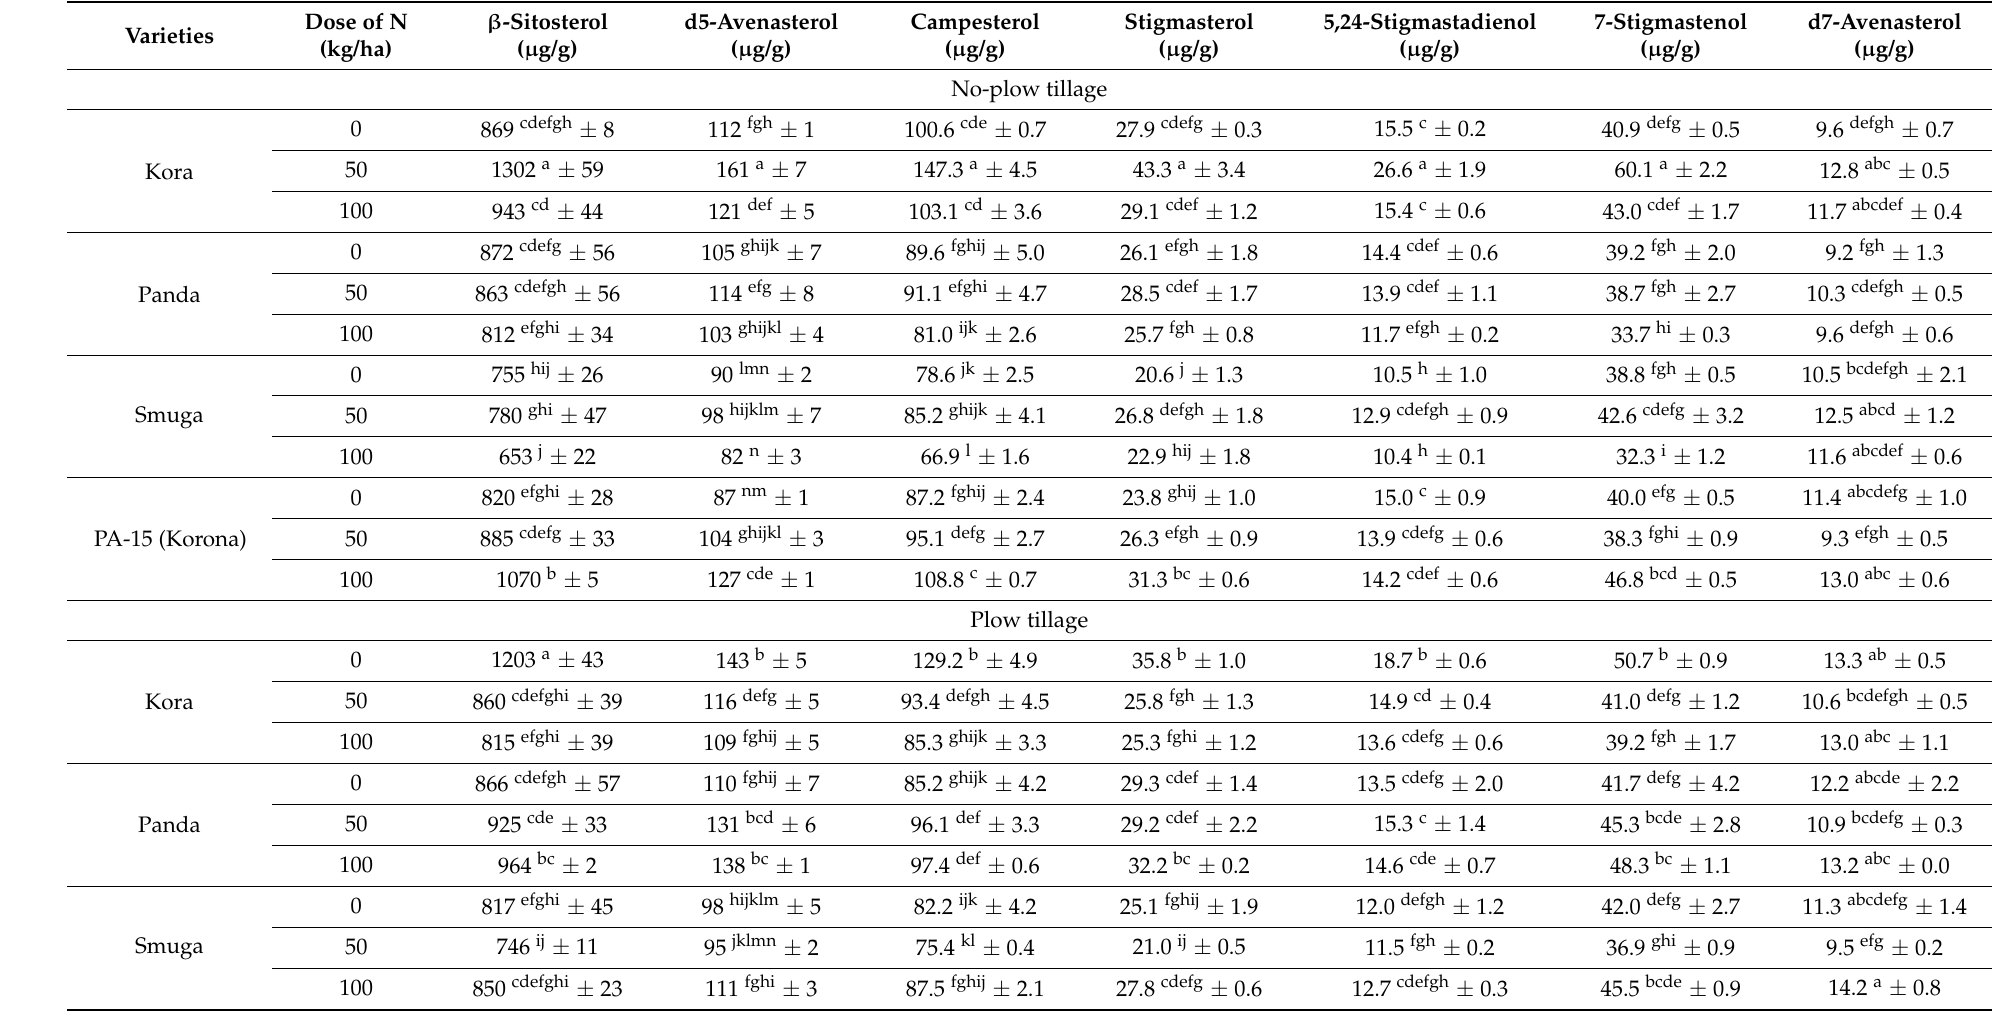
Table 2. Phytosterol content of four varieties of no-plow tillage and plow tillage common buckwheat, by fertilization doses.